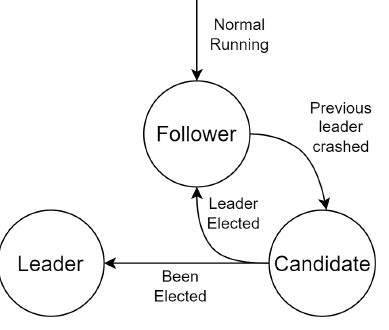
Figure 4. The role transition of swarm